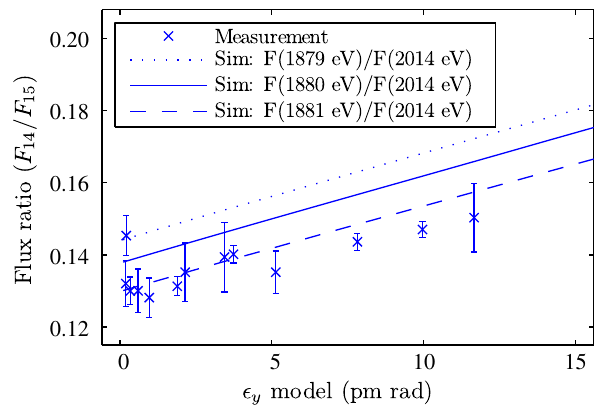
FIG. 8. Magnification of Fig. 7 for small vertical emittances.